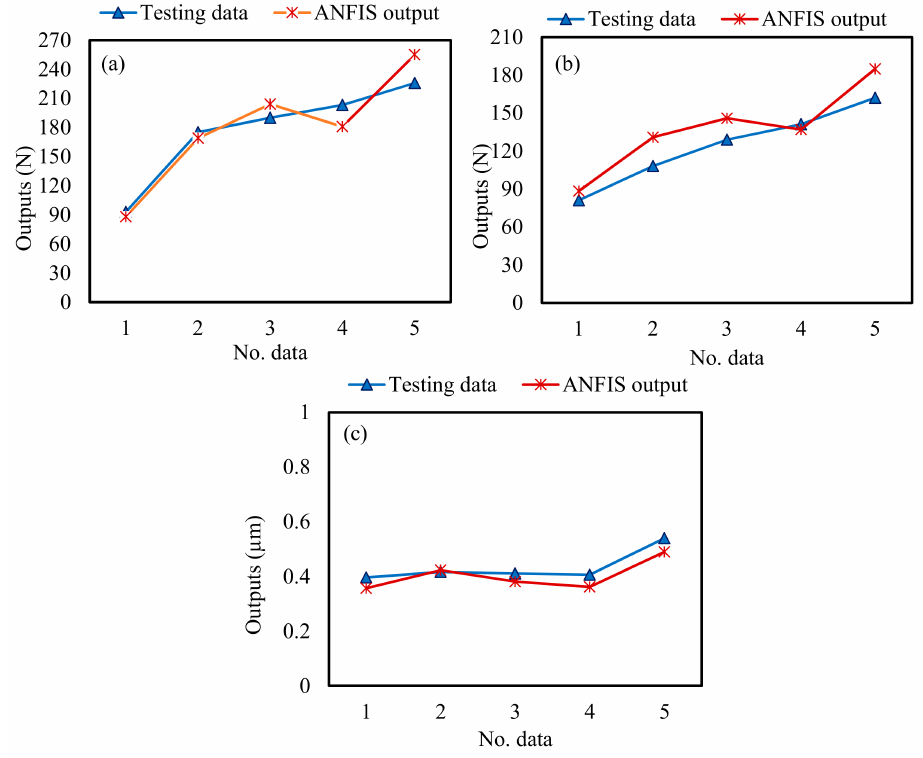
Figure 7. Comparison between the testing data and ANFIS outputs: ( a ) depth force; ( b ) feed force; ( c ) surface